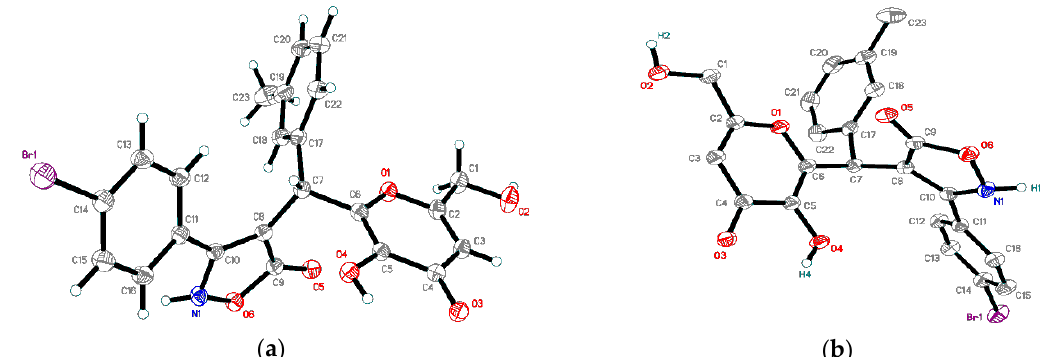
Figure 1. The structure of compound 4 (XRD—X-ray Diffraction). The crystal is a racemate, which contains enantiomers ( a ) and ( b ).